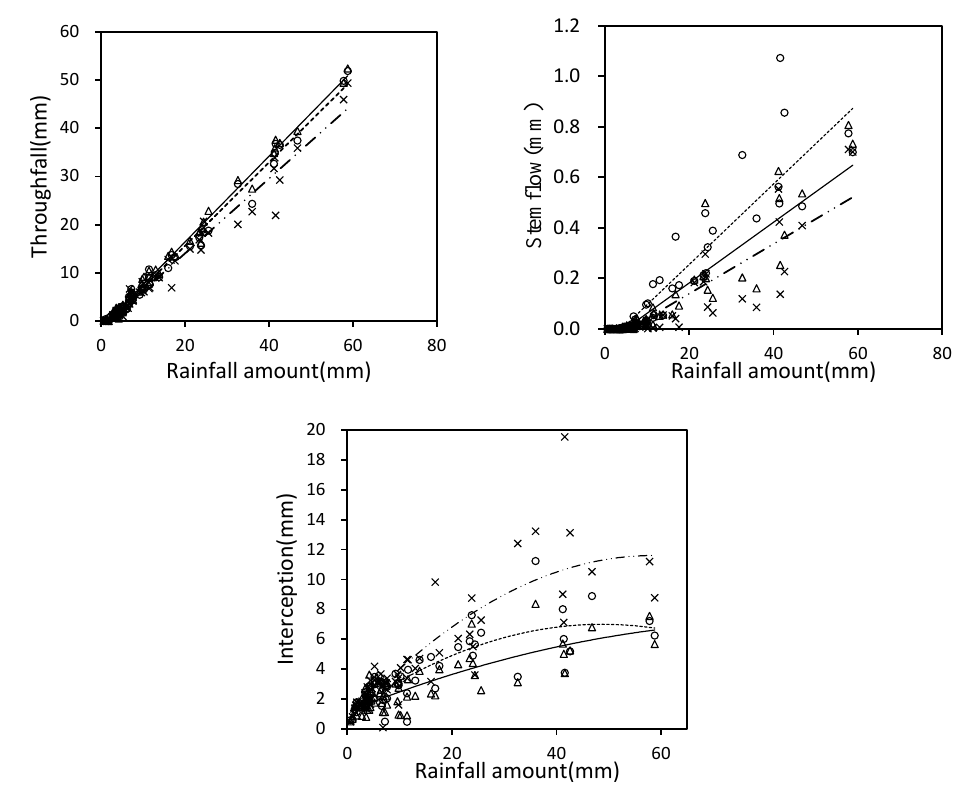
Figure 4. Linear relationship between throughfall, stemflow, interception with gross rainfall for three Chinese pine forest stands. Total of 64 rainfall events. △ : 40-year-old stand, ○ : 50-year-old stand, ×: 60-year-old. Table 5. Linear relationship between throughfall, stemflow, interception with gross rainfall in three Chinese pine forest stands, with a total of 64 rainfall events. Item